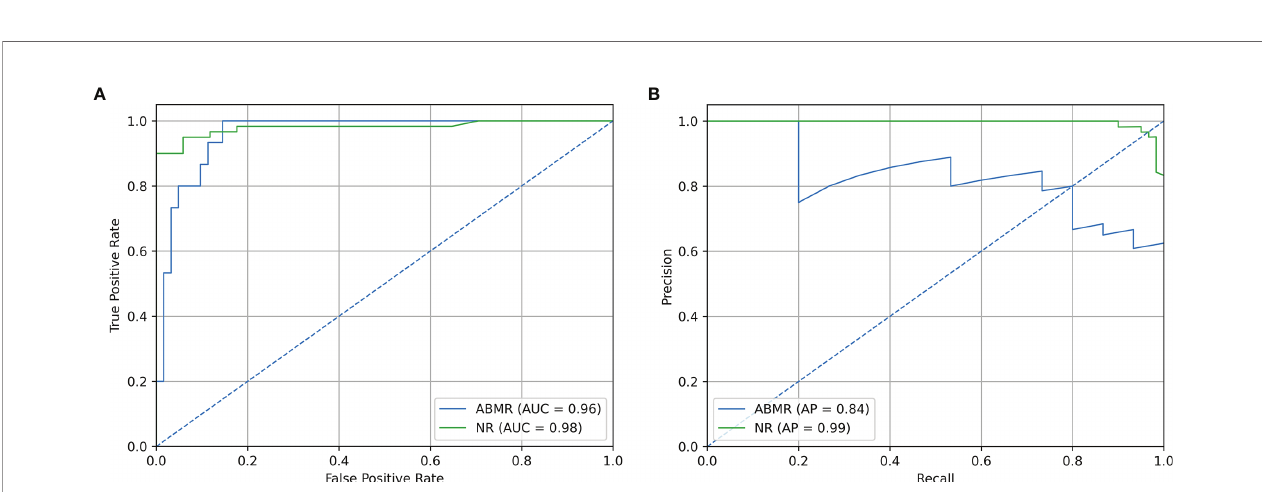
FIGURE 6 | Validation Set Performances. (A) ROC curve of independent validation within GSE129166 of the B-HOT+ model. (B) Precision/Recall curve of independent validation within GSE129166 of the B-HOT+ model. ABMR, Antibody-Mediated Rejection; AP, Average Precision; AUC, Area Under the ROC Curve; B-HOT, Banff- Human Organ Transplant; NR, Non-Rejection; ROC, Receiver operating characteristic.